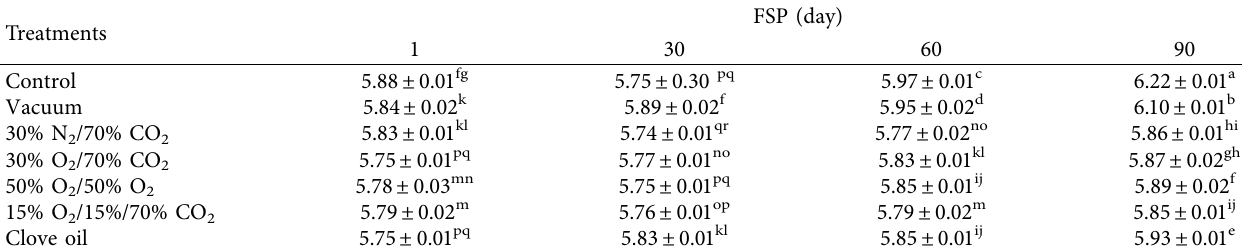
Table 1: Impact of average gas sulfa MAP and FSP on the CTMP